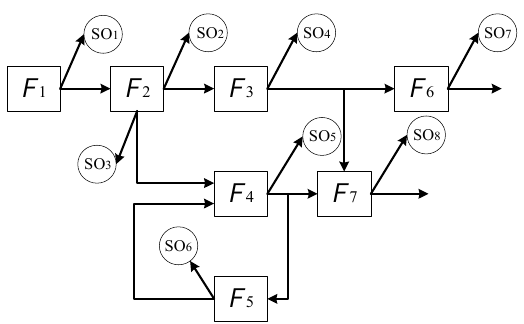
Figure 5. The dependency graphic model of the controller.